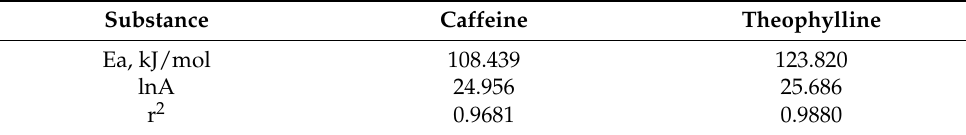
Figure 6. Calculation of the parameters of the Arrhenius equation for caffeine ( a ) and theophylline ( b ). Table 2. Kinetic parameters from the Arrhenius Table 2. Kinetic parameters from the Arrhenius equation.